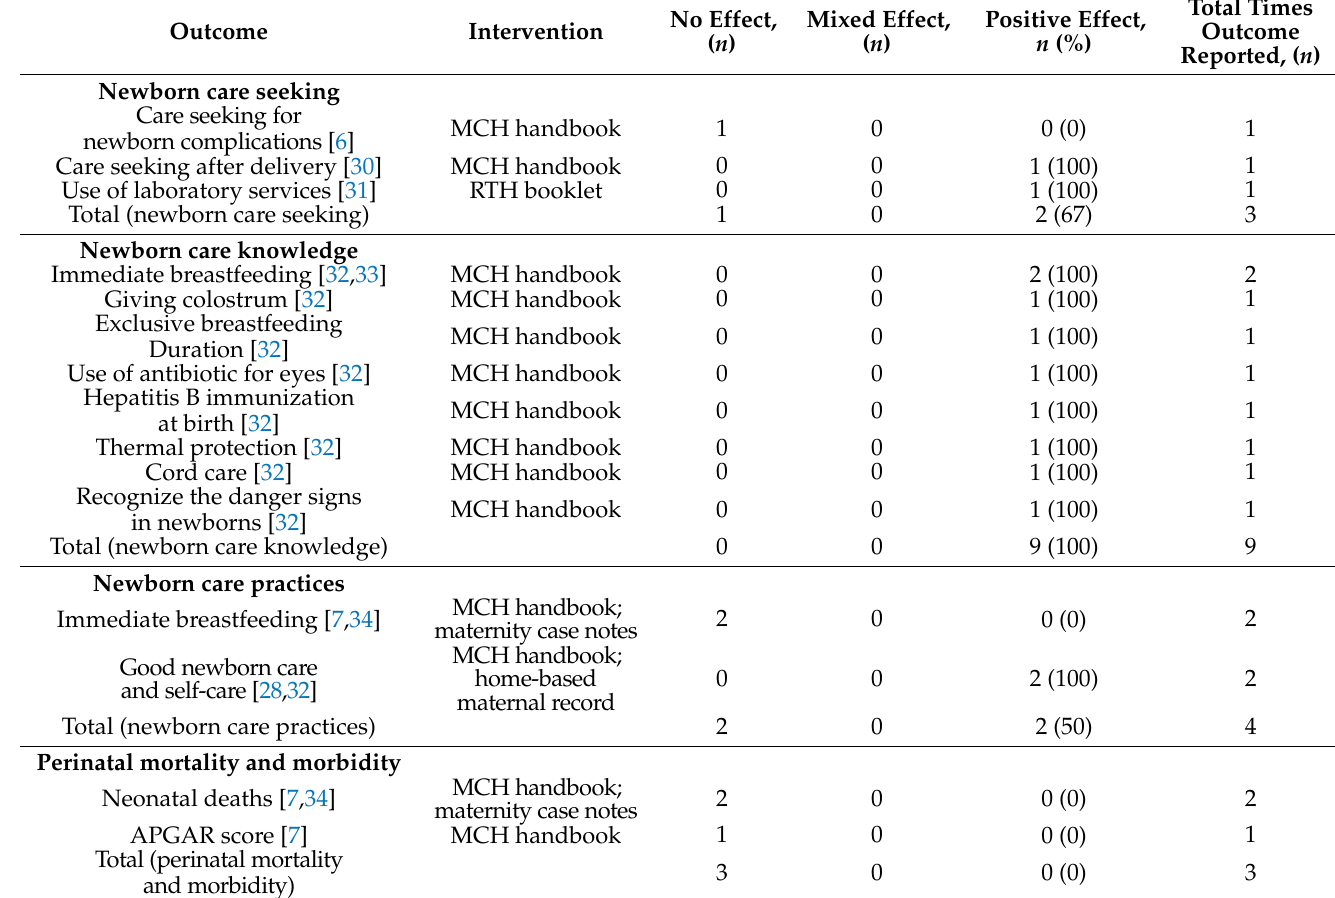
Table 1. Roles of the MCH handbook and other home-based records on newborn health. Outcome Intervention